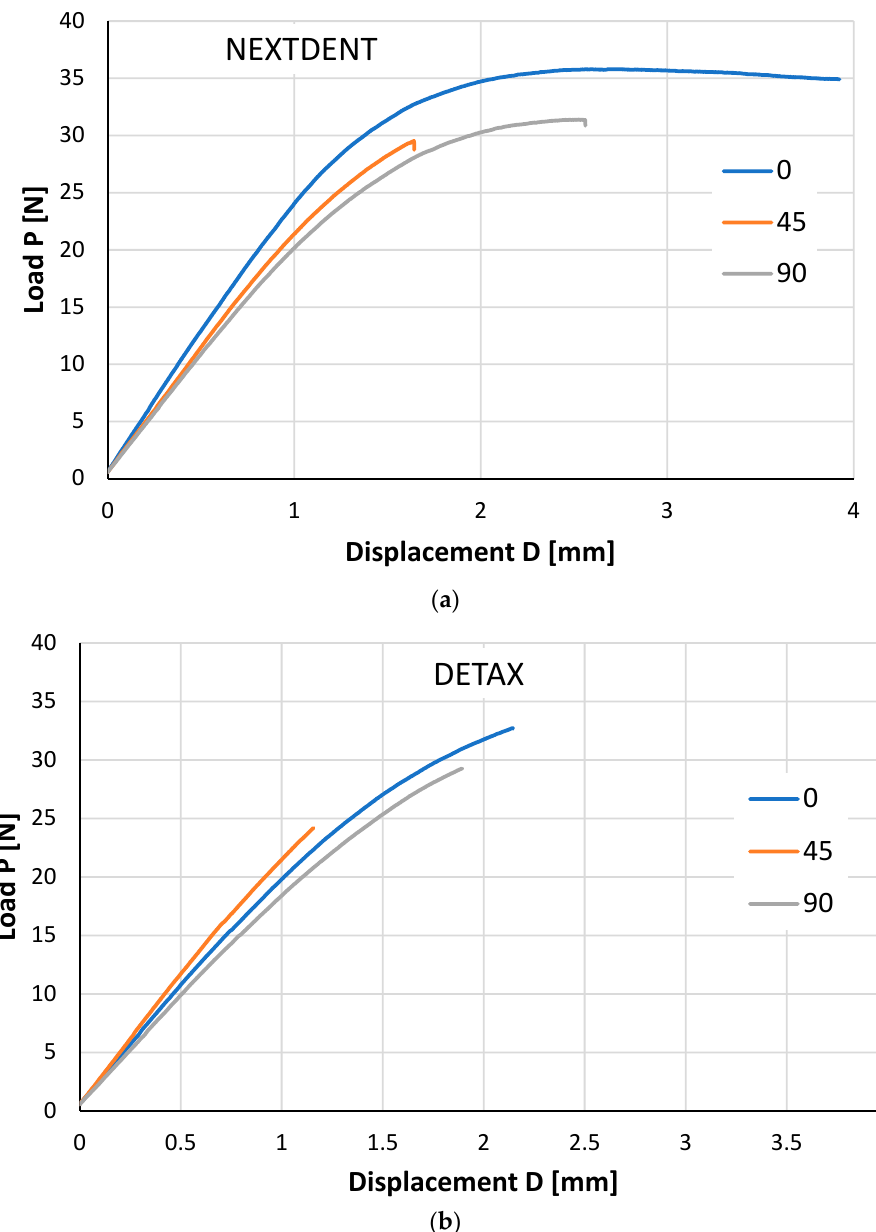
Figure 3. Typical load–displacement curves for different printing directions. ( a ) NEXTDENT; ( b ) DETAX. For the specimens printed at 0° angle, the load was applied perpendicular and par- allel to the growth direction of the specimens (Figure 4).